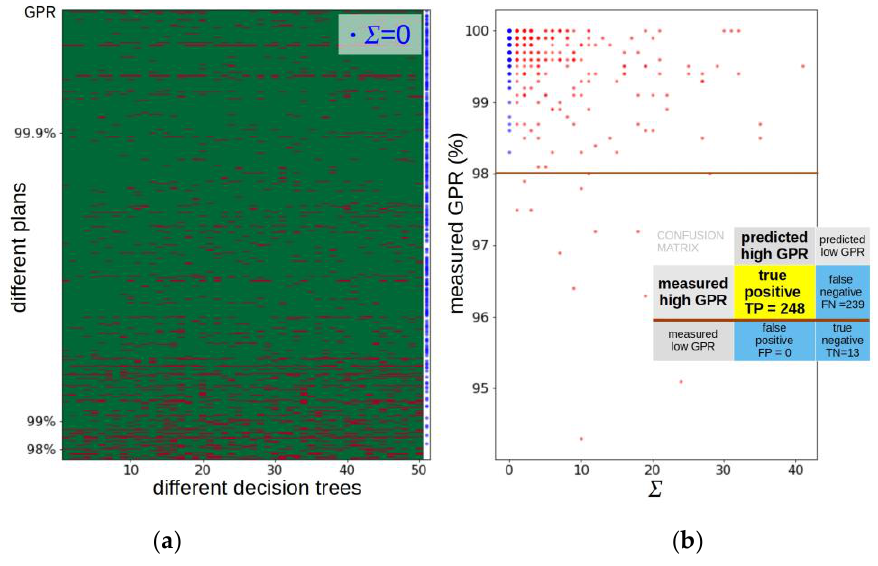
Figure 1. Example of prediction results. ( a ) Fifty trees (columns) tested on 500 plans (rows). Red boxes indicate values below the cut-off threshold (98 + 1)%. Blue dots on the right side mark the plans with no red boxes ( Σ = 0). The plans are sorted by GPR, from smallest at the bottom to largest at the top. ( b ) The GPR value for each plan is presented as a function of Σ , with Σ = 0 dots in blue, and Σ > 0 in red. Due to the rounding, many dots overlap. The dots in the upper left corner represent half of all test plans.